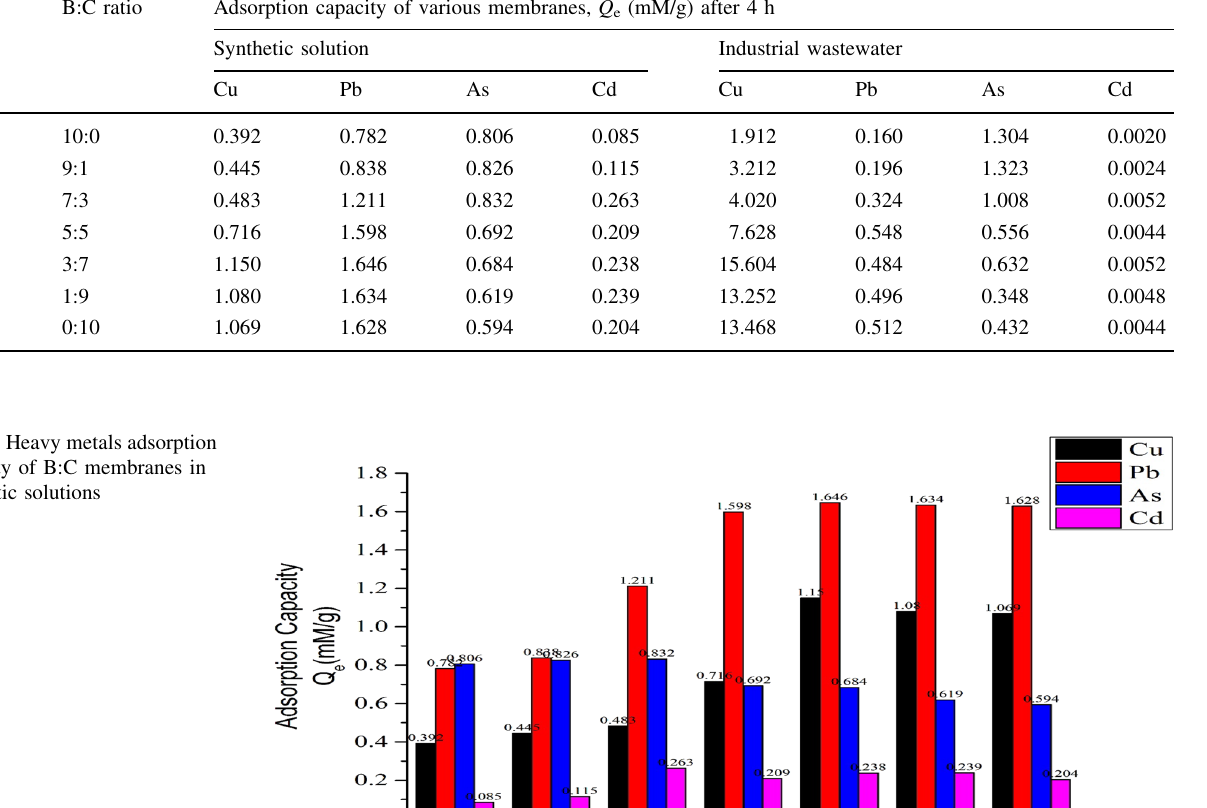
Table 3 Adsorption capacity of chitosan-modified biochar membranes in a synthetic solution S. no.